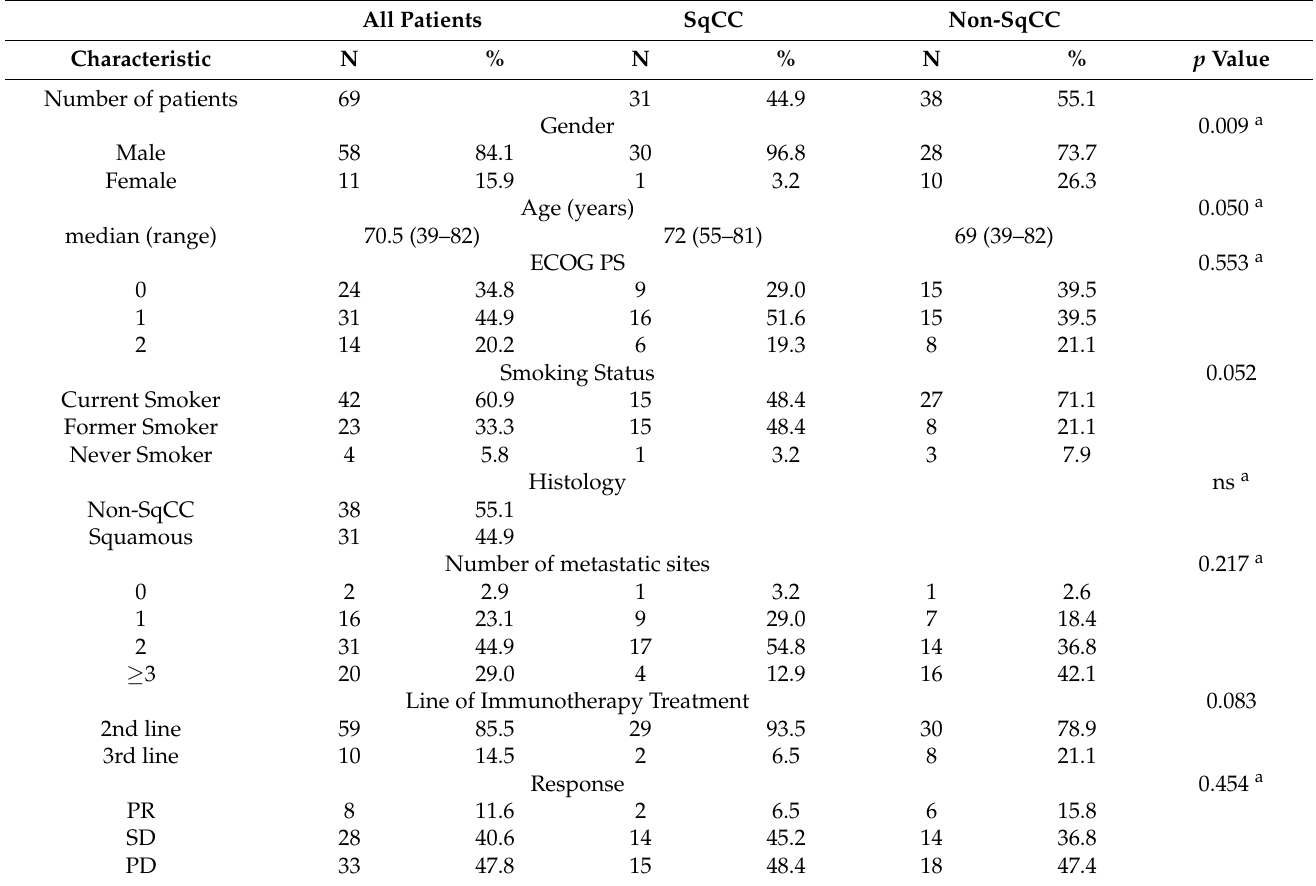
Table 1. Clinicopathological Characteristics of